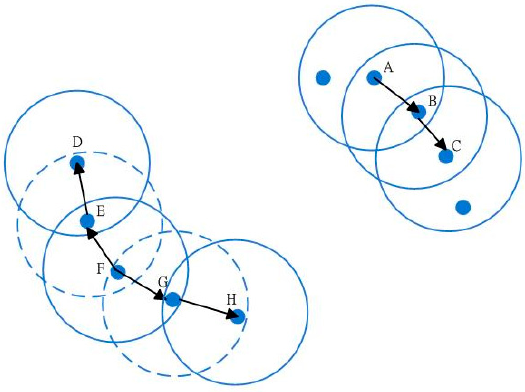
Figure 4. Density-reachable and density-connected.